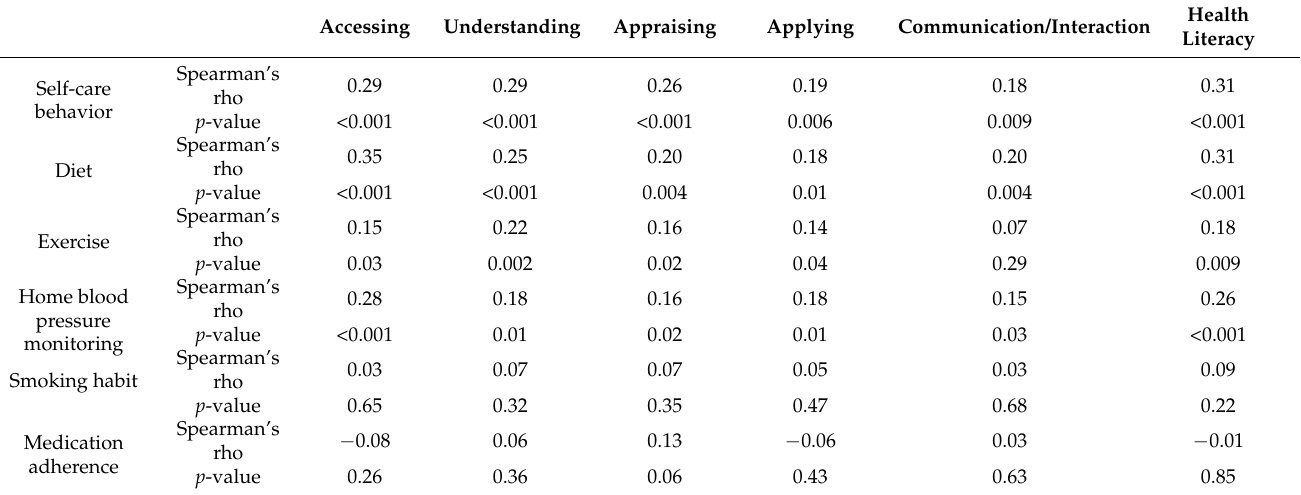
Table 2. Correlation between self-care behavior and health literacy using spearman analysis. Accessing Understanding